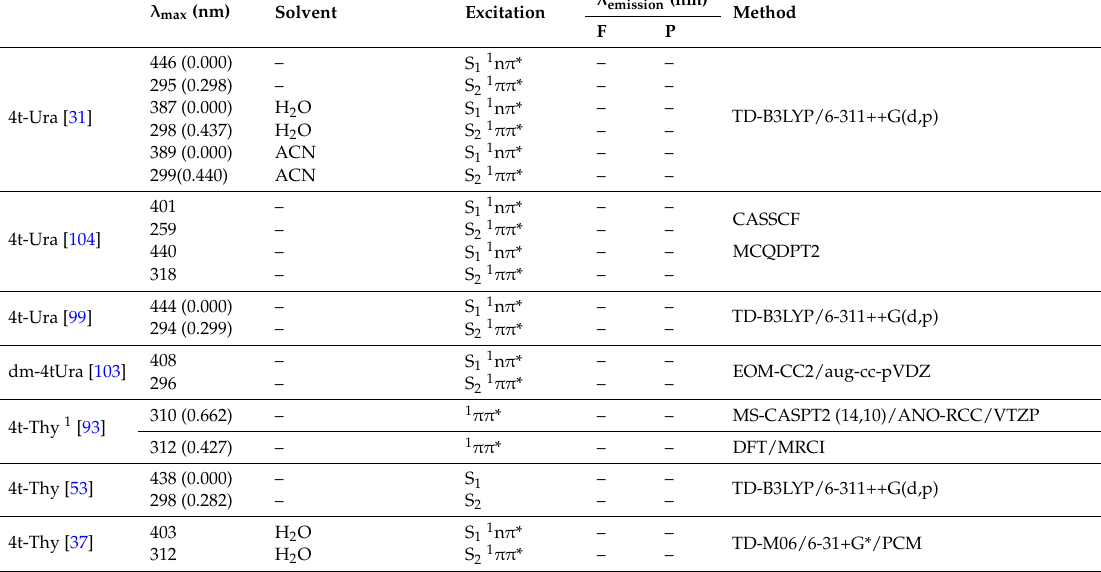
Table 7. Computed absorption and emission properties of 4-thiopyrimidine derivatives. In parenthesis the oscillator strengths are shown. F: Fluorescence; P: